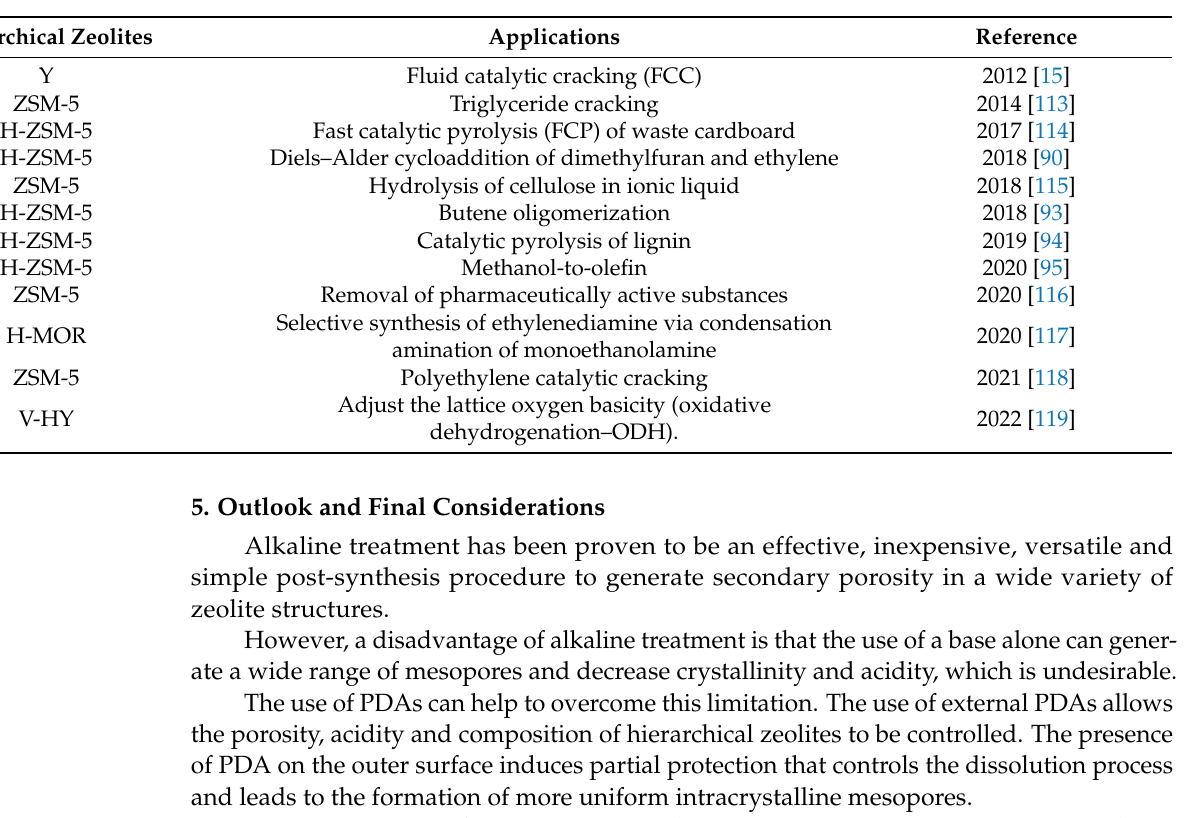
Table 3. Summary of applications of hierarchical zeolites prepared by alkaline treatment cited in these